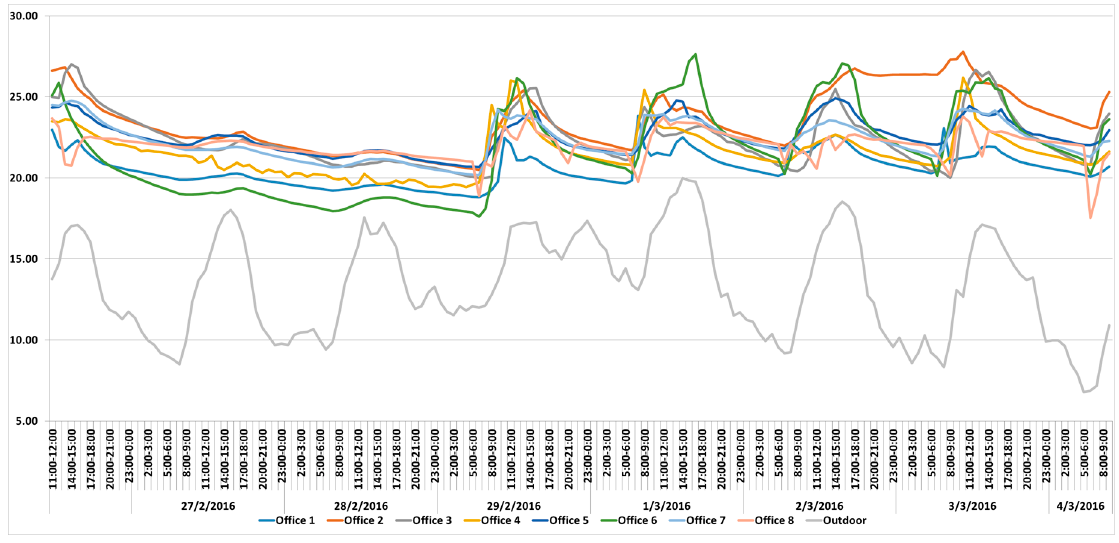
Figure 4. Temperature levels of external and all the indoor environment of Building B during winter.